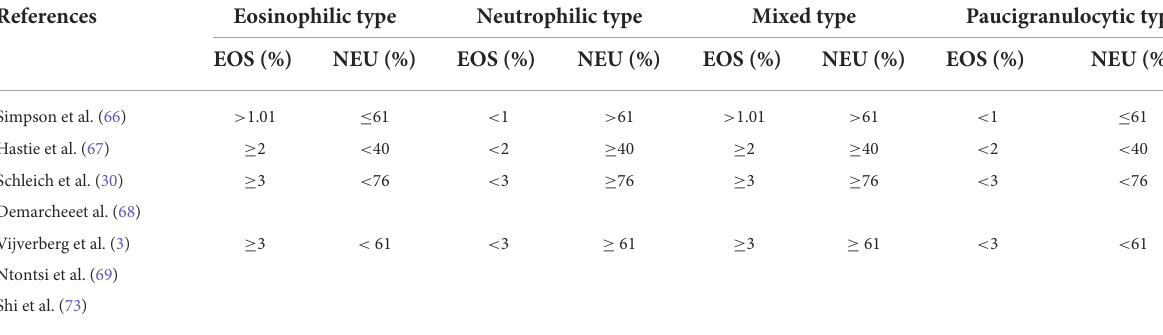
TABLE 3 Cut-off values for the different induced sputum inflammatory phenotypes.